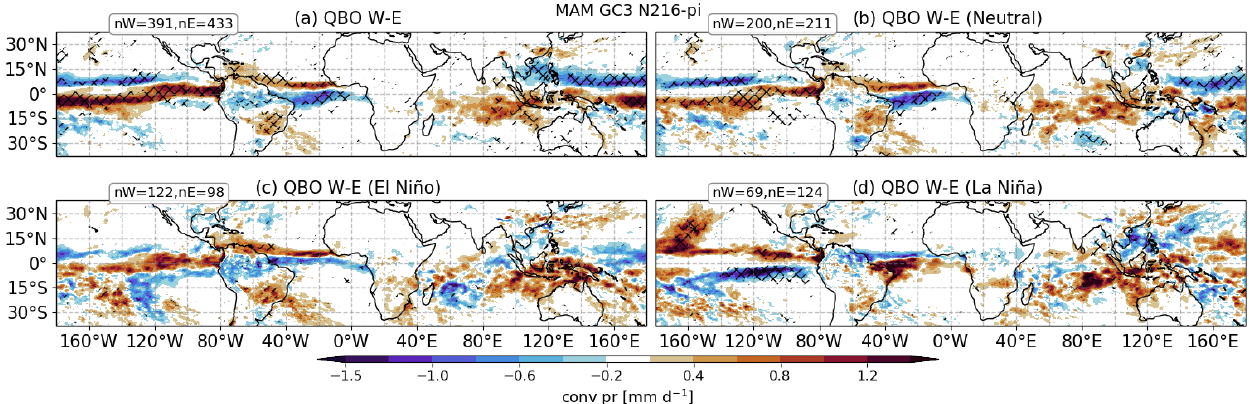
Figure 8. Composite convective precipitation differences (QBO W–E) in MAM for GC3 N216-pi for (a) all the months and (b) ENSO-neutral conditions only, (c) El Niño and (d) La Niña. The sample size of each composite is noted in the top left corner of each panel. Statistically significant differences to the 95% confidence level are shown through the